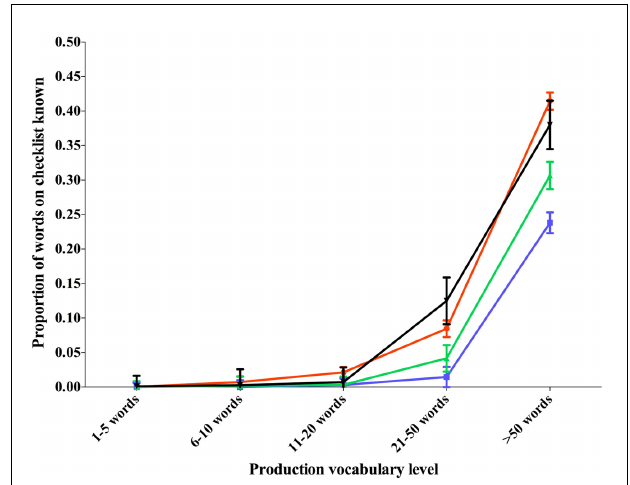
FIGURE 3 | Proportion of words in different categories produced by children of different vocabulary levels.